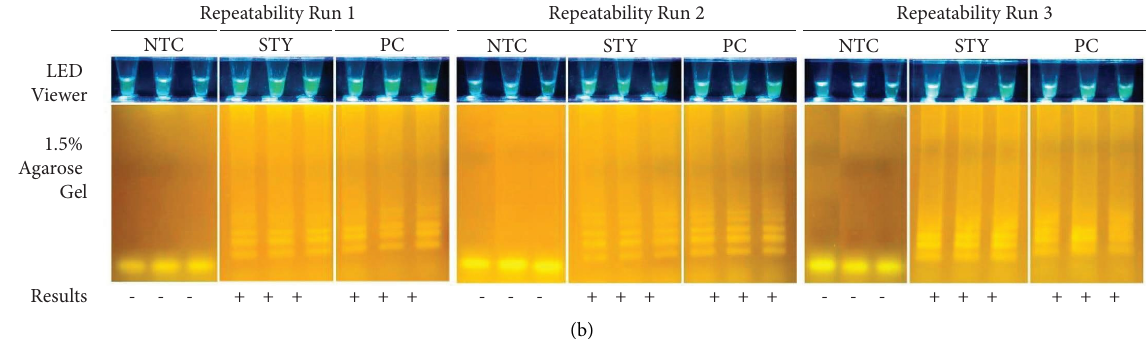
Figure 7: Assay repeatability. Tree diferent QUASR LAMP assays were done by the same operator over three days using samples in triplicate. Sample (2.5 μ L) was added to 10 μ L reagent mix then incubated at 65 ° C for 60 minutes, 80 ° C for 2 minutes, and cooled to 4 ° C for